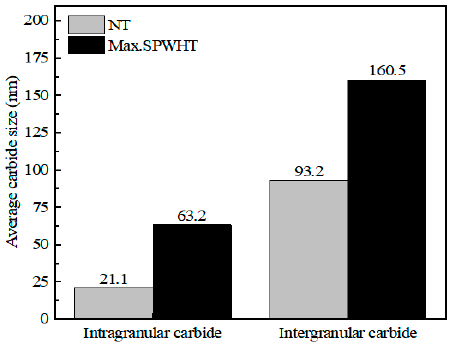
Figure 6. Average size change of carbide in the 2.25Cr1Mo0.25V steel after Max.SPWHT.